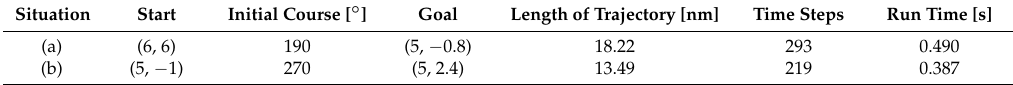
Table 5. Initial inputs and simulation results for U-shaped obstacles.